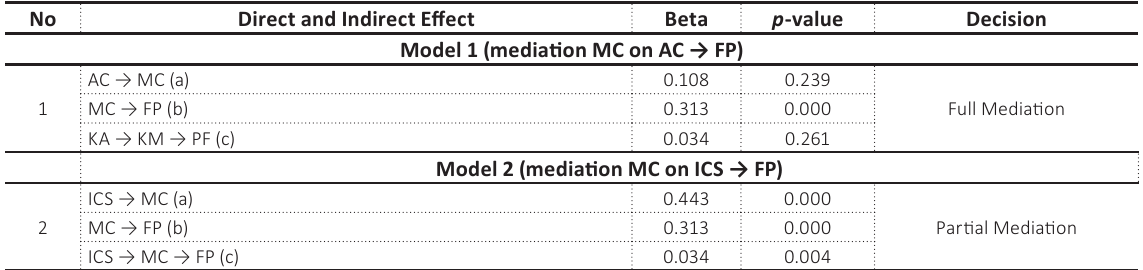
Table 6. Mediating effect